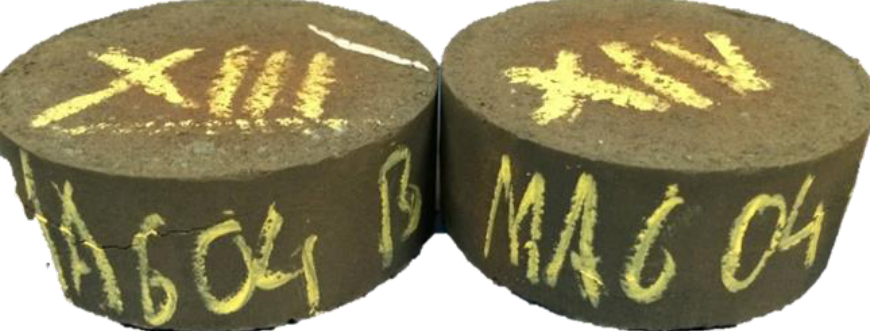
Figure2. PhotographoftheMA604Bbriquettesmanufacturedwitha10N / mm 2 Figure 2. Photograph of the MA604B briquettes manufactured with a 10 N/mm 2 manufacturing pressure.